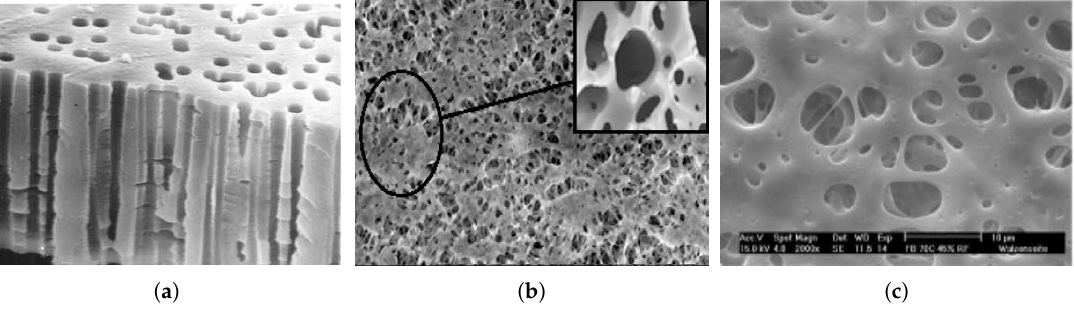
Figure 1. Magnified membranes with various pore distributions and sizes; ( a – c ) are from [8–10],